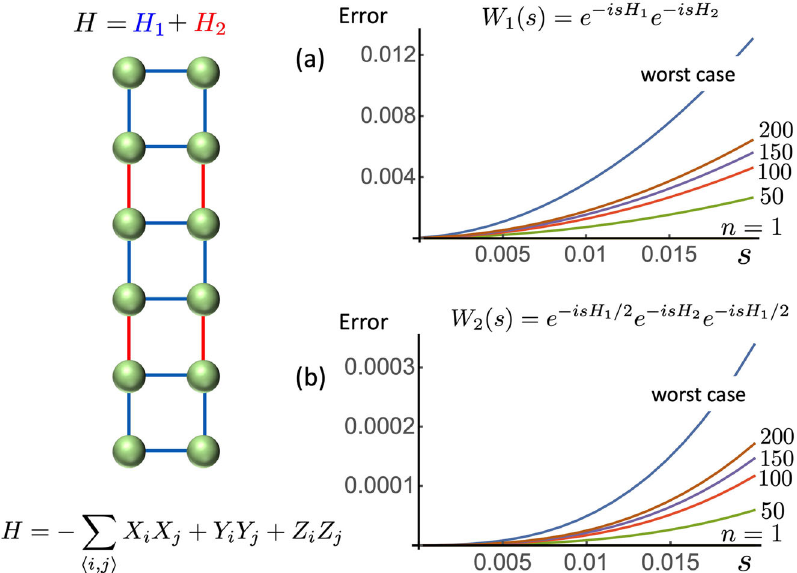
Fig. 1 Worst case vs. low-energy Trotter errors: errors induced by product formulas for a 2 × 6 Heisenberg spin-1/2 model. The Hamiltonian is H = − ∑ 〈 i , j 〉 X i X j + Y i Y j + Z i Z j , where X i , Y i , and Z i are the Pauli operators for the i th spin, and H = H 1 + H 2 , where H 1 and H 2 are the interaction terms represented by blue and red bonds, respectively. a The evolution operator for time s , U ( s ) = e − isH , is approximated by the fi rst order product formula W 1 ð s Þ ¼ e (cid:3) isH 1 e (cid:3) isH 2 . The plot shows the largest approximation errors when acting on various low-energy subspaces associated with increasing energies, labeled by n = 1,50, 150, 200, and in the worst case. b Similar results for when the evolution operator U ( s ) = e − isH is approximated by the second order product formula W 2 ð s Þ ¼ e (cid:3) isH 1 = 2 e (cid:3) isH 2 e (cid:3) isH 1 = 2 .